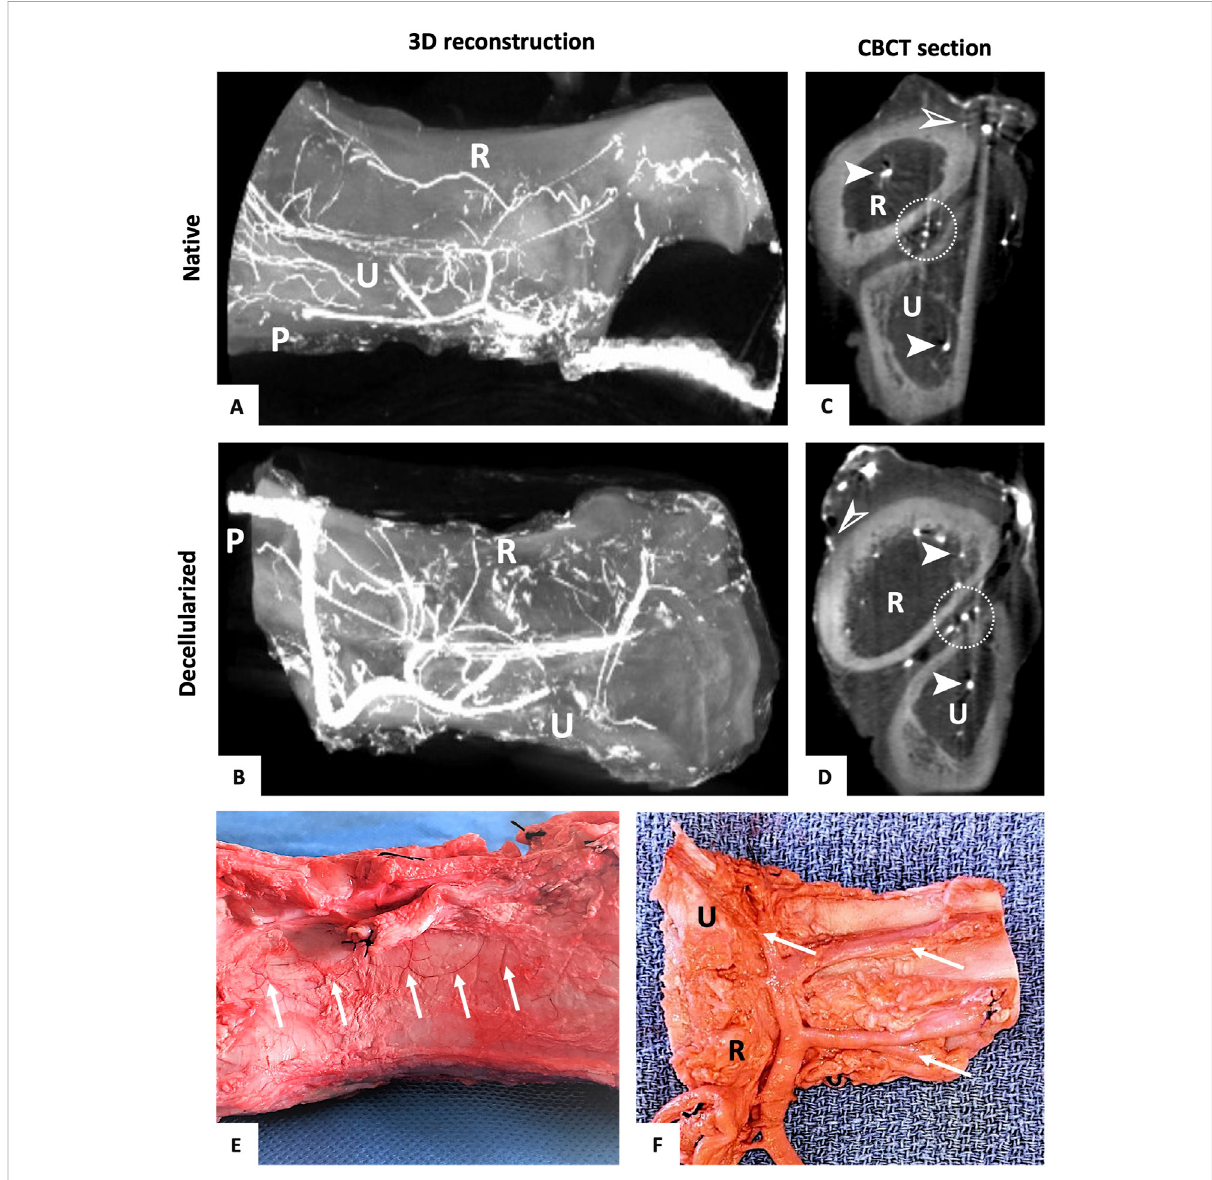
FIGURE 4 Vascularization of the vascularized bone graft. (A – F) : 3D reconstruction of the forelimb graft before (A) and after decellularization (B) showing the vascular tree preservation (R = radius, U = ulna, p = pedicle). CBCT transversal section of barium sulphate injected into the forelimb bone graft before (C) and after perfusion decellularization (D) (R = radius, U = ulna) showing the perfusion of barium sulphate into endomedular vessels ( ➤ ), interosseous vessels (white circle), and subperiosteal vessels ( ➢ ) before and after decellularization. Identi fi cation of the preserved periosteal vascular network (white arrows) (E) and intra-osseous perforators (white arrows) (F) after dissecting a latex-injected decellularized bone graft (R = radius, U =